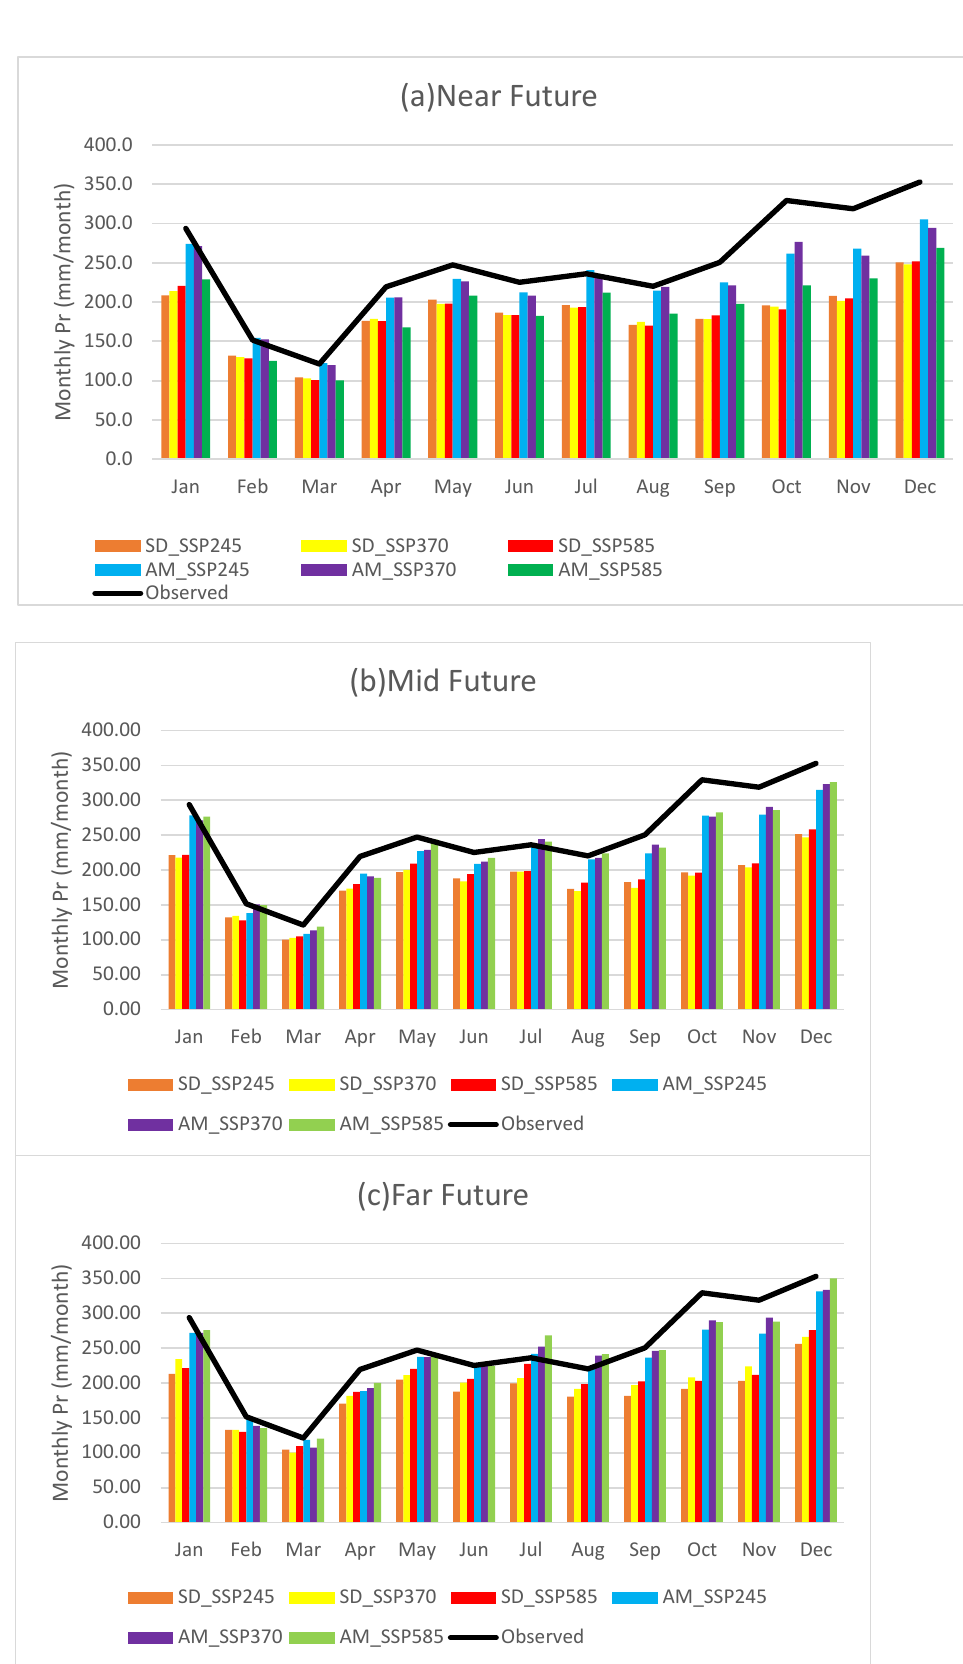
Figure 5. Comparison of monthly average precipitation based on SD and AM model for ( a ) near future period; ( b ) mid future period; and ( c ) far future period.